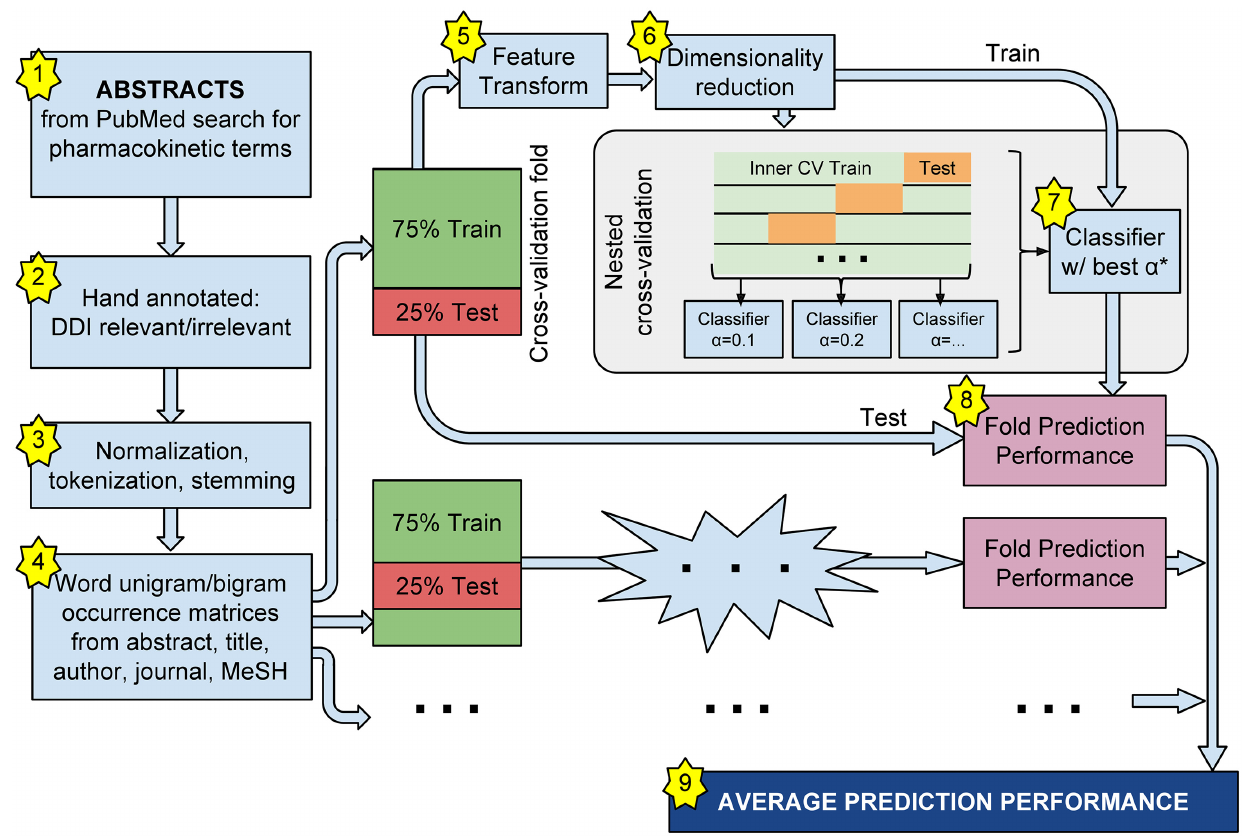
Fig 1. Literature mining pipeline. The basic steps of the literature mining pipeline include selection of corpus documents, hand-labeling of ground truth assignments, extraction and normalization of textual features, and computation of unigram/bigram occurrences matrices. Cross-validation folds are used to estimate generalization performance of classifier and feature transform configurations, while nested (inner) cross-validation folds are used to choose classifier hyperparameters.